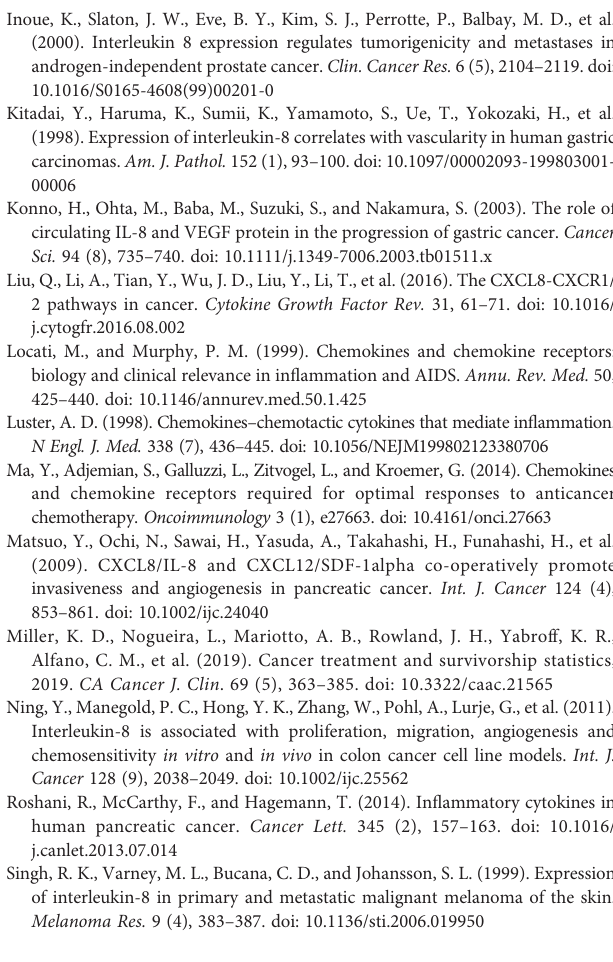
SUPPLEMENTARY FIGURE 1 | Top 10 hub genes calculated by maximal clique centrality in Cytoscape. SUPPLEMENTARY FIGURE 2 | (A) The relation between CXCL8 protein expression and tumor size. Tumor size < 5 cm (N = 64), tumor size ≥ 5 cm (N = 23). (B) Therelationbetween CXCL8 proteinexpression andtumortype. Masstype(N= 45), ulcer type (N = 41). SUPPLEMENTARY FIGURE 3 | (A) The relation between CXCL8 protein expression and CEA. (B) The relation between CXCL8 protein expression and CA19-9. CEA, carcinoembryonic antigen; CA19-9, carbohydrate antigen 19-9. SUPPLEMENTARY FIGURE 4 | (A) Expression of RPS6KB1 mRNA expression in normal (N = 70), CRC-nonmetastasis (N = 58) and CRC-metastasis (N = 12) groups. (B) Expression of CREB1 mRNA expression in normal (N = 70), CRC- nonmetastasis (N = 58) and CRC-metastasis (N = 12) groups. (C) Expression of BAD mRNA expression in Normal (N = 70), CRC-nonmetastasis (N = 58) and CRC- metastasis (N = 12) groups. Statistical signi fi cance was performed by the Mann- Whitney U test. *** p <